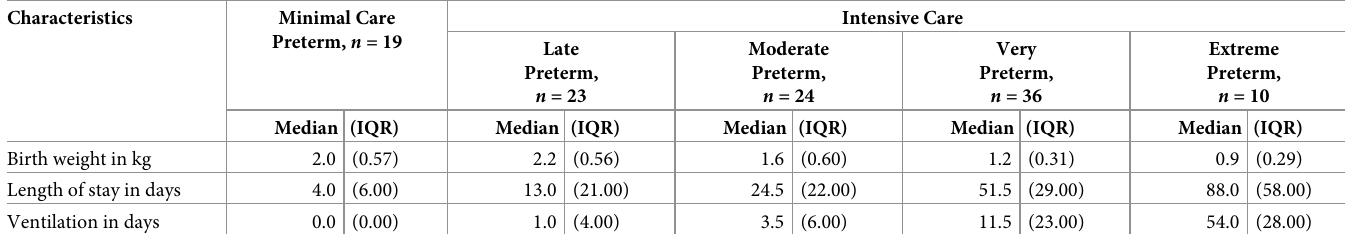
Table 2. Preterm characteristics.